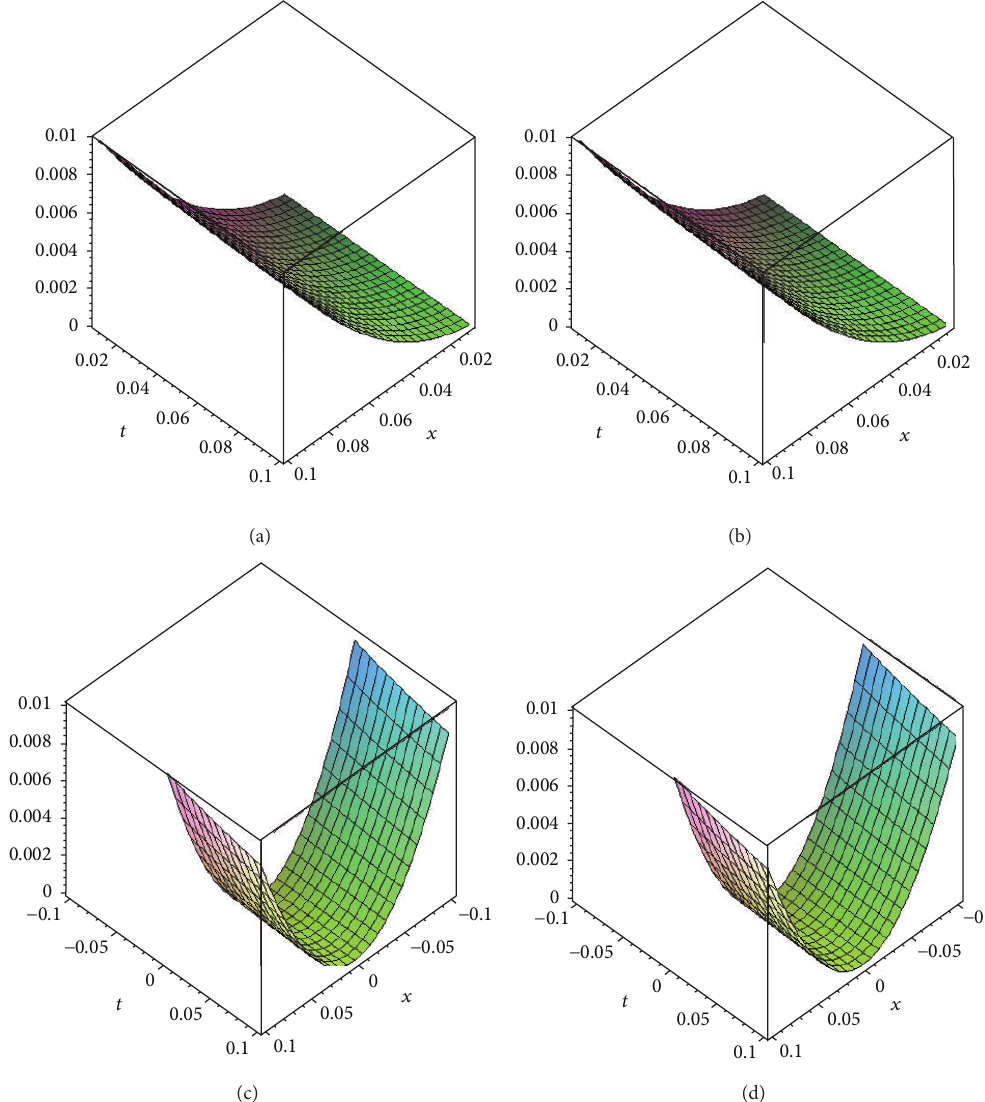
Figure 4: (a) ADM solution of Example 2 for 𝛼 = 1.5 (b) Multivariate Pad´e approximation of ADM solution for 𝛼 = 1.5 in Example 2 (c) ADM solution of Example 2 for 𝛼 = 1.75 (d) Multivariate Pad´e approximation of ADM solution for 𝛼 = 1.75 in Example 2.